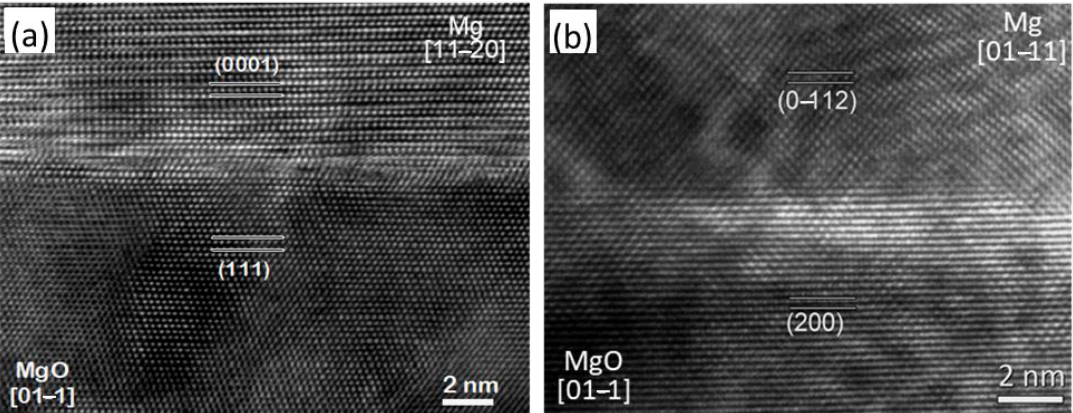
Figure 25. Evidence of heterogeneous nucleation of Mg on MgO particle substrate [40,71]. HR-TEM images viewed in ( a ) [1 1 2̅ 0]Mg // [0 1 1̅ ]MgO, and ( b ) [0 1 1̅ 1]Mg // [0 1 1̅ ]MgO direction, respectively, showing the well defined orientation relationships (ORs) between ( a ) Mg and {1 1 1}Mg, and ( b ) Mg and {1 0 0}MgO.